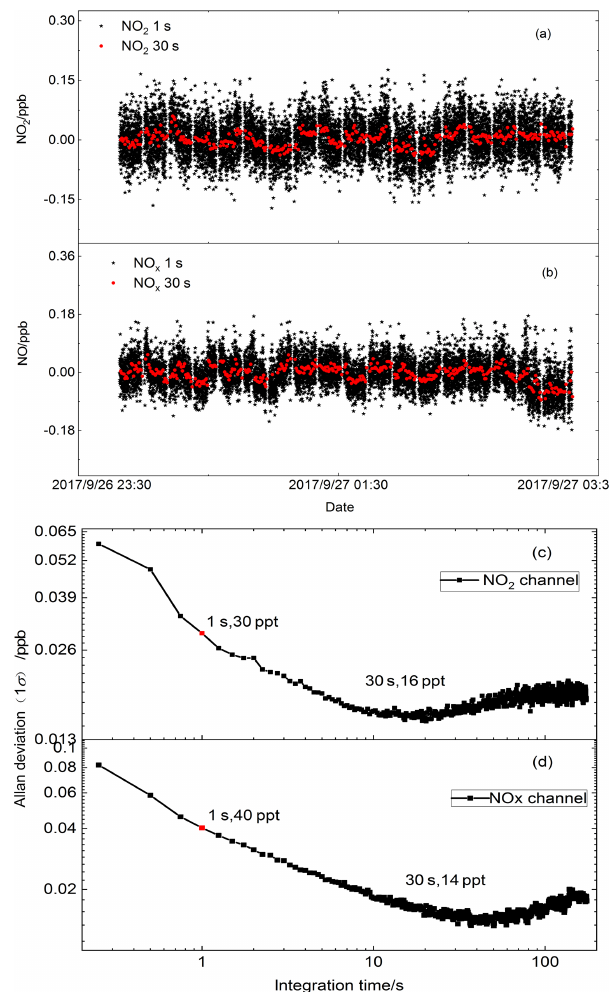
Figure 4. (a, b) Continuous time series measurement when the in- strument sampled only zero air, averaged to 1s for NO 2 and NO x channels (black dots); the red dots show the data averaged to 30s. (c, d) Allan deviation plots for NO 2 concentration in two channels. The minimum value equals the optimum integration